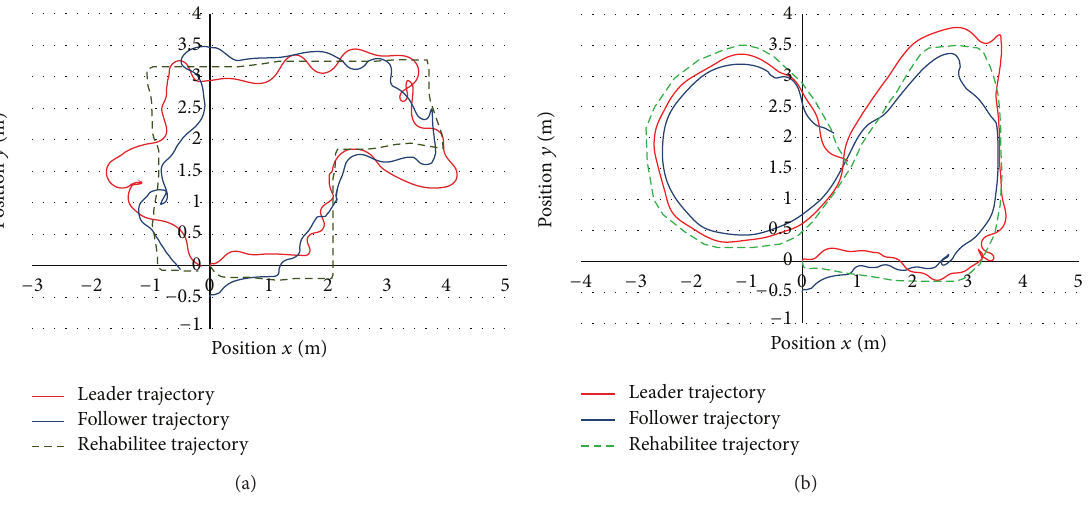
Figure 8: Computer simulation results of generated